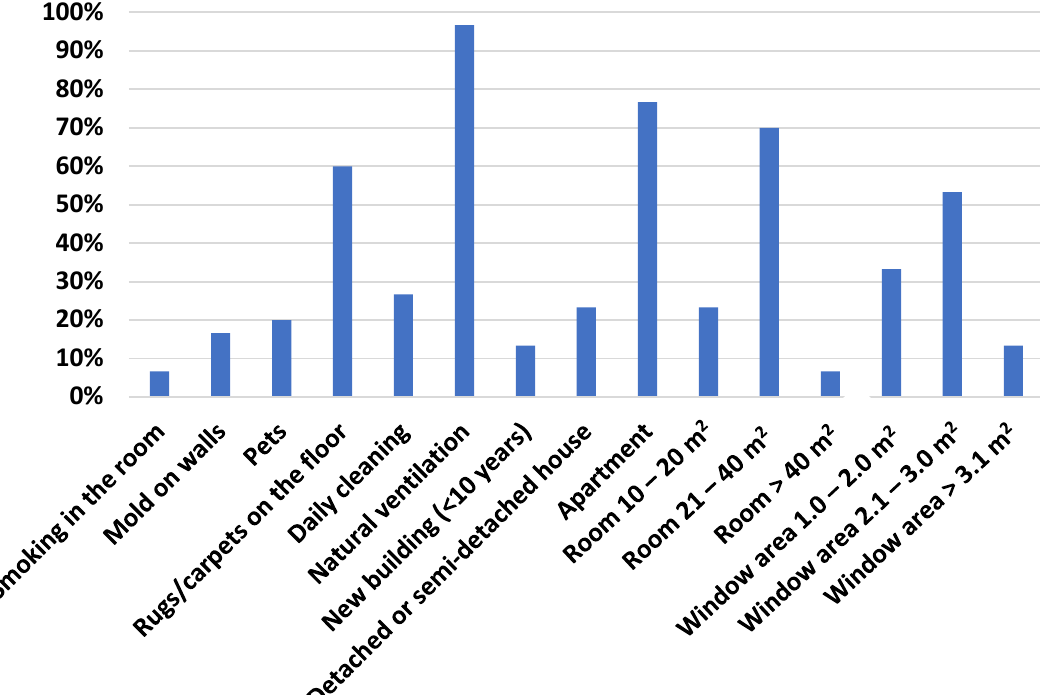
Figure 2. Frequencies of the main features of the houses and rooms where samples were obtained.